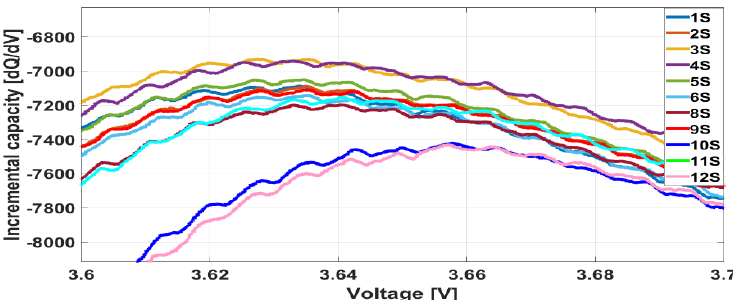
Figure 19. IC curve valley point 1 of the 12 series ‐ connected stage of the retired series/parallel battery